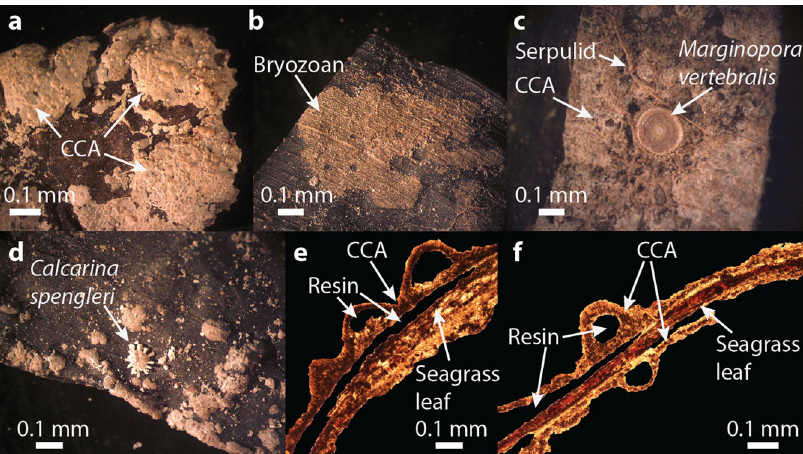
Fig. 1 Examples of seagrass epibionts. (bryozoans, serpulids, foraminifera and Crustose Coralline Algae, CCA) under the binocular microscope ( a – d ), and thin section images of cross-sections through blocks of dried seagrass leaves embedded in resin ( e , f